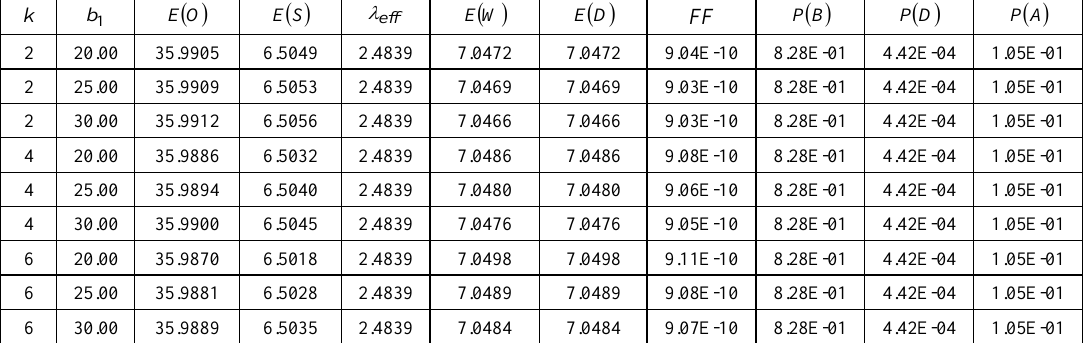
Table 5. Performance measures by varying the number of phases for repair ( ) k and the repair rate ( ) k